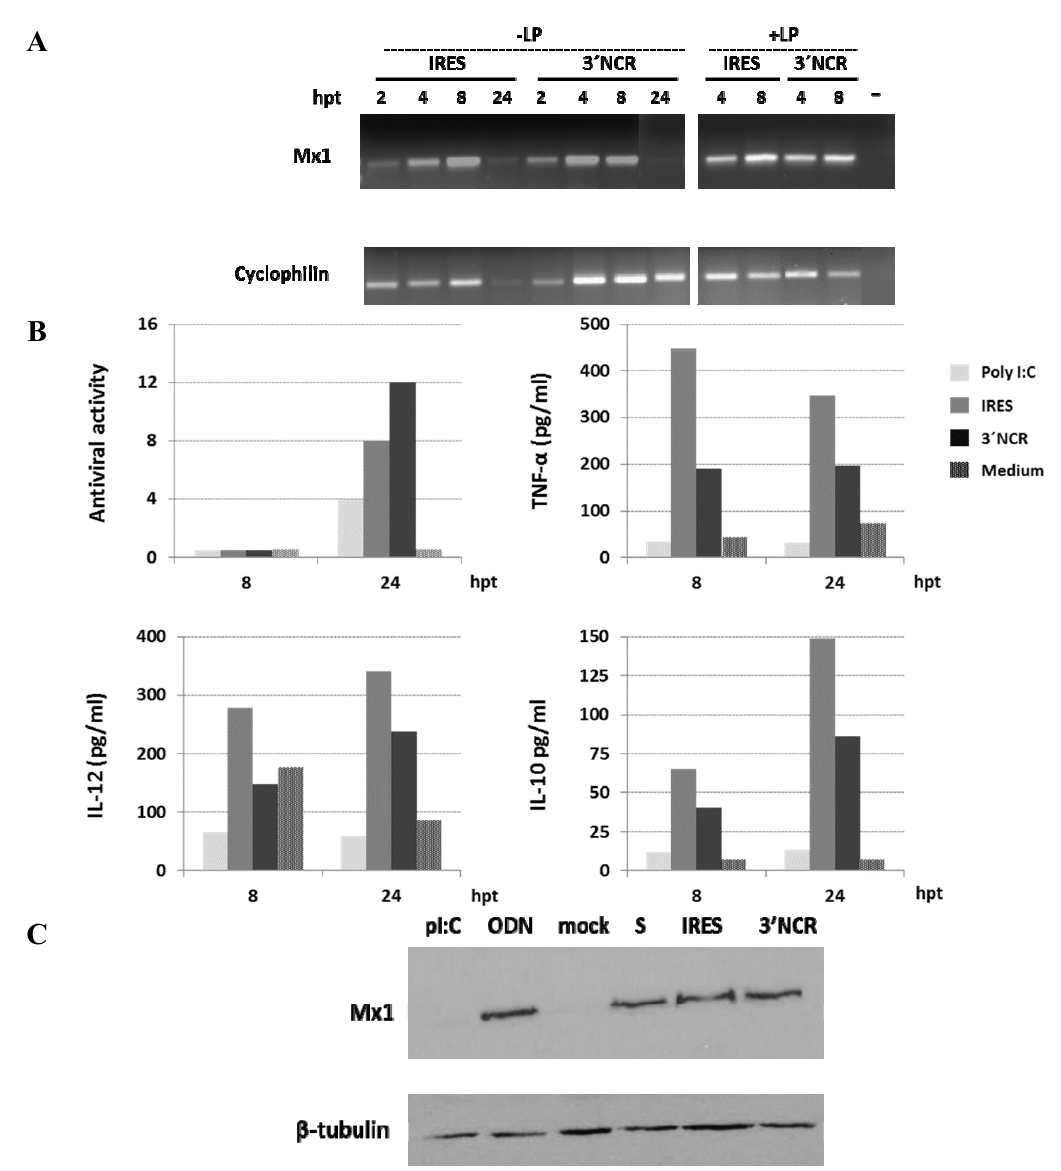
Figure 3. Analysis of the innate immune response of transfected PBMCs from a single pig (six month-old) over time. ( A ) Swine PBMCs were transfected with 20 μ g/mL IRES or 3 ′ NCR transcripts, with or without Lipofectin, and RNA was extracted at 2, 4, 8 or 24 h pt. Amplification of Mx1 and cyclophilin mRNAs by RT-PCR is shown; ( B ) Antiviral activity, TNF α , IL-12 and IL-10 levels in supernatants of swine PBMCs (2 × 10 6 ) transfected with 3 ′ NCR or IRES as in A or stimulated with poly I:C (10 μ g/mL), and collected at 8 or 24 h pt. Mock transfections with culture medium and Lipofectin were performed as negative controls. Antiviral activity is expressed as the reciprocal of the highest dilution of supernatants from transfected PBMCs causing a 50% reduction of the cytophatic effect induced by infection with FMDV on IBRS-2 cells. The levels of the different cytokines were measured by ELISA; ( C ) Immunoblot detection of Mx1 in lysates of PBMCs transfected with S, IRES, 3 ′ NCR transcripts (20 μ g/mL) or mock-transfected using Lipofectin, or stimulated with poly I:C or ODN (both at 10 μ g/mL). Cells were lysed 24 h pt. Tubulin was used for normalization.